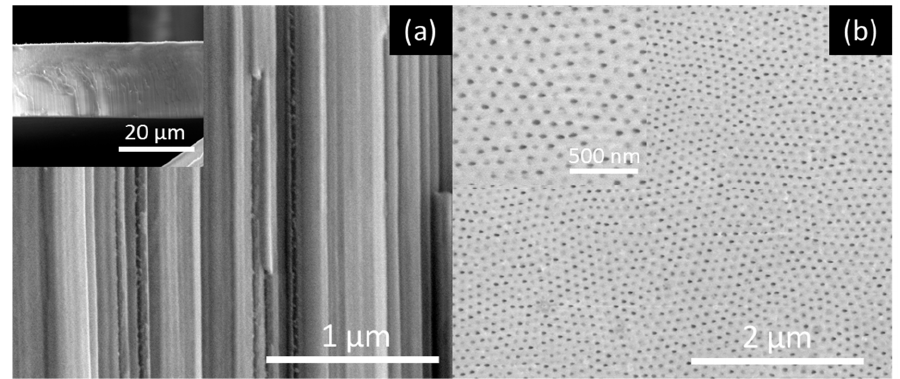
Figure 4. Charge curves during the first hour of anodization for the EG, FA, NMF and DMSO samples.